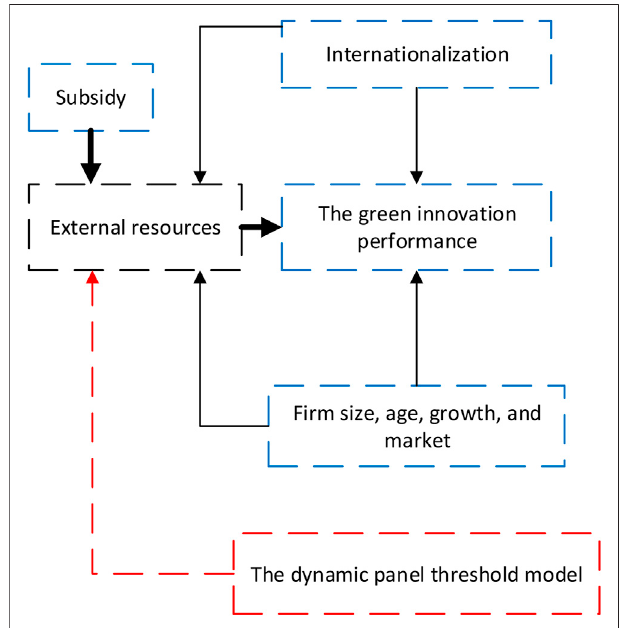
FIGURE 1 | The logical